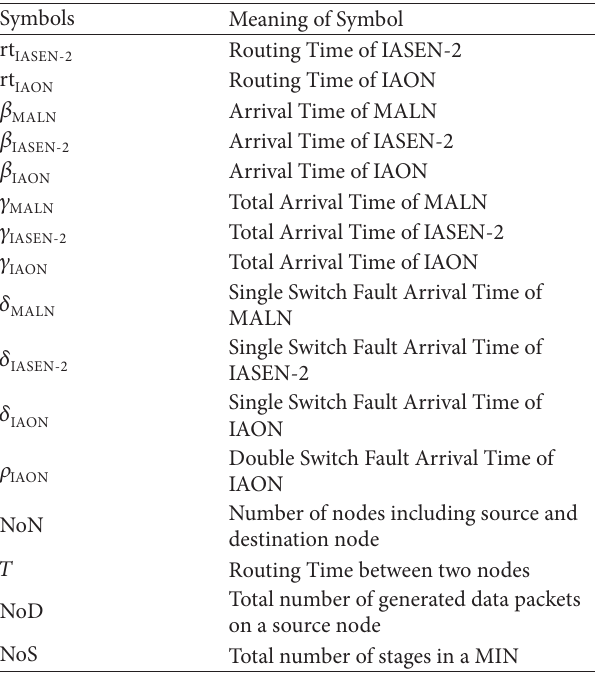
Table 1: Various symbols and their meanings. Symbols